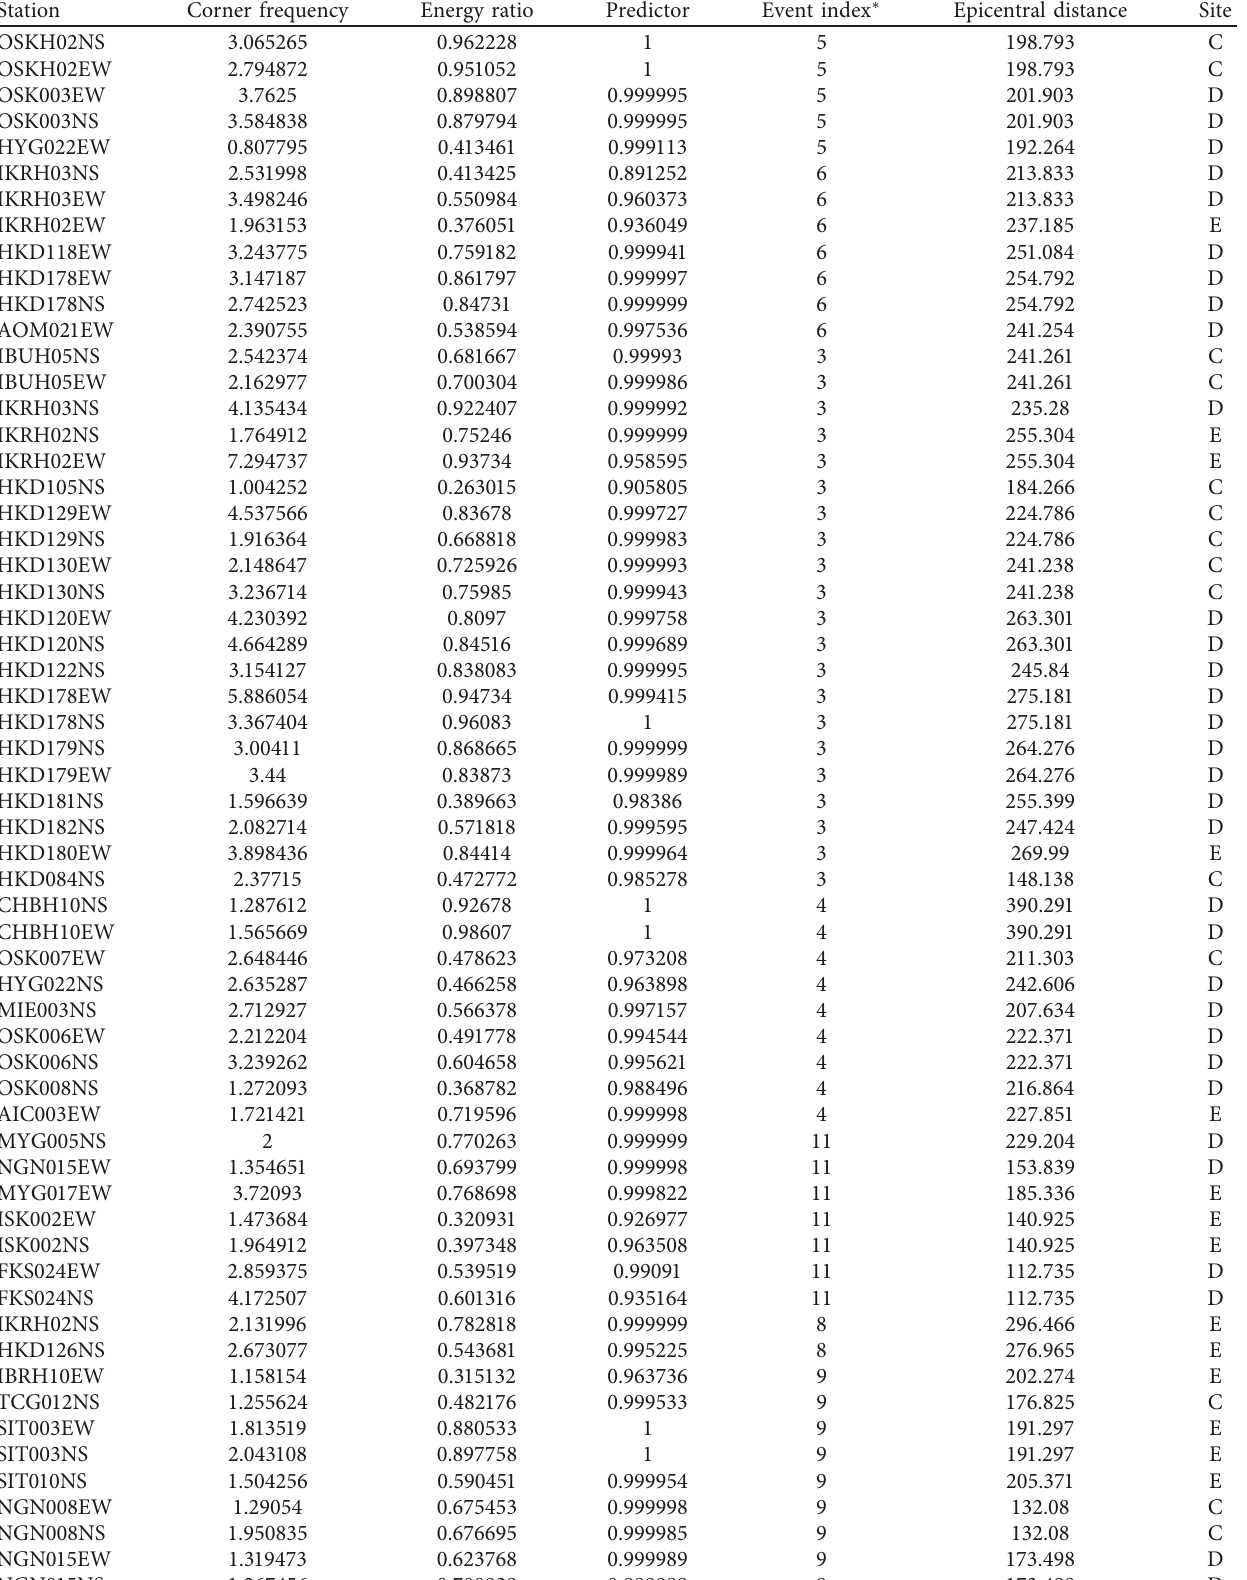
Table 2: Records identified as long-period ground motions by using the proposed